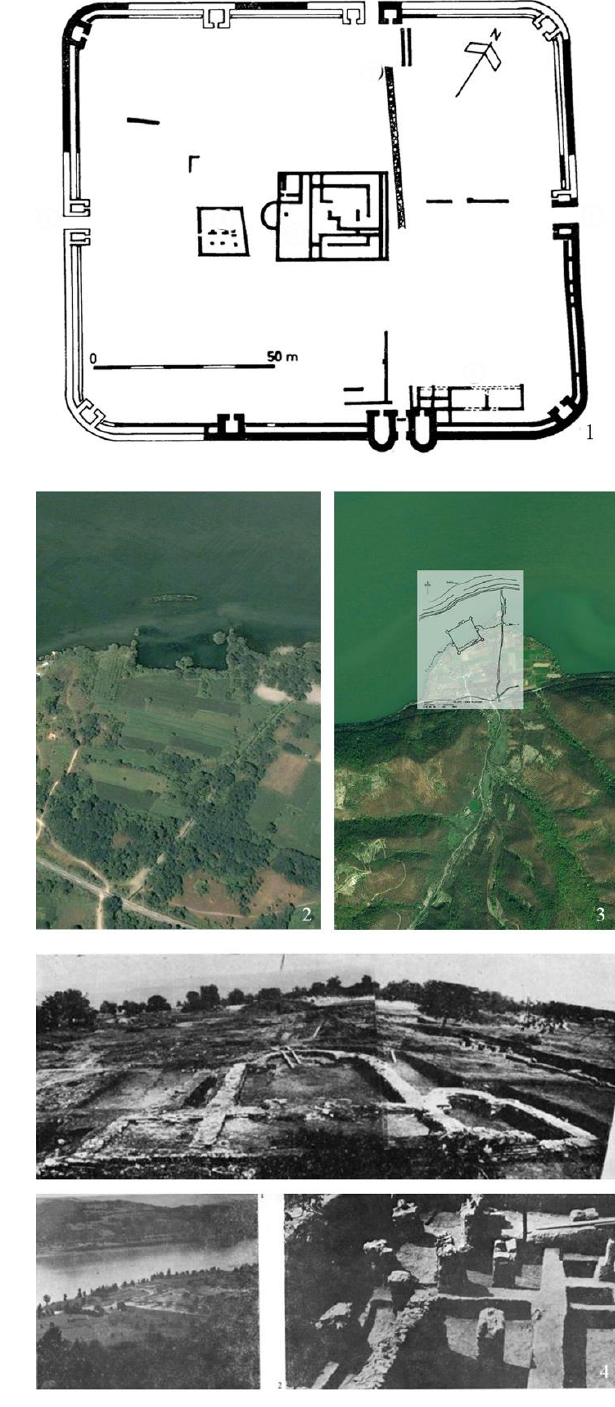
Figure 2. Archaeological sites belonging to the VI century mapped by the author.